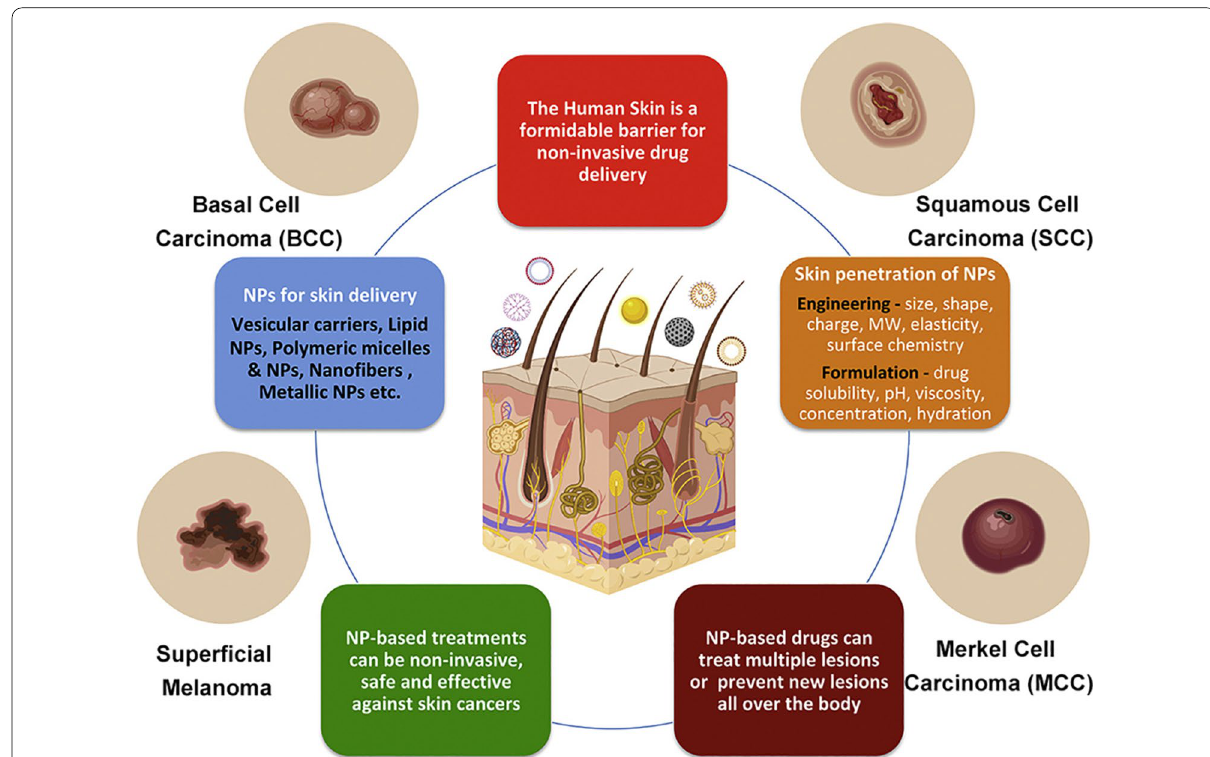
Fig. 2 Types of skin cancers and use of nanoparticles in the treatment of the disease. Reproduced with permission from Krishnan and Mitragotri